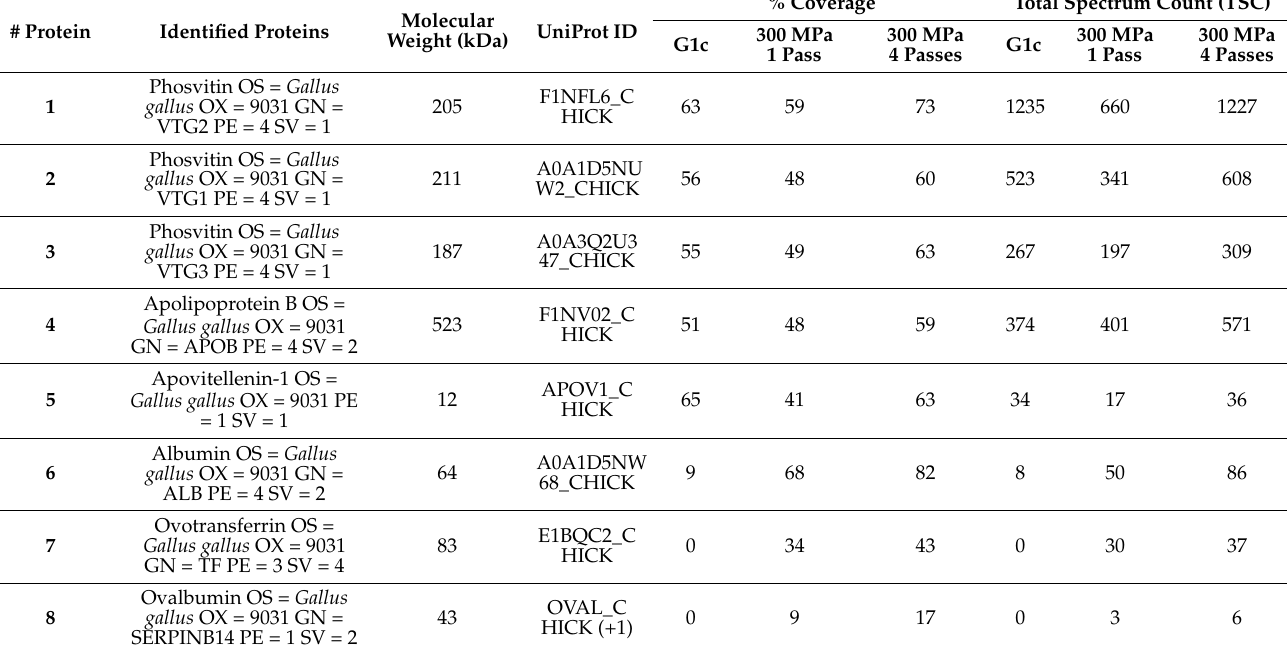
Table 2. Proteomic analysis of native PAGE wells of initial granule (G1c), pressure-treated granule (G1p) at 300 MPa—1 pass and pressure-treated granule (G1p) at 300 MPa—4